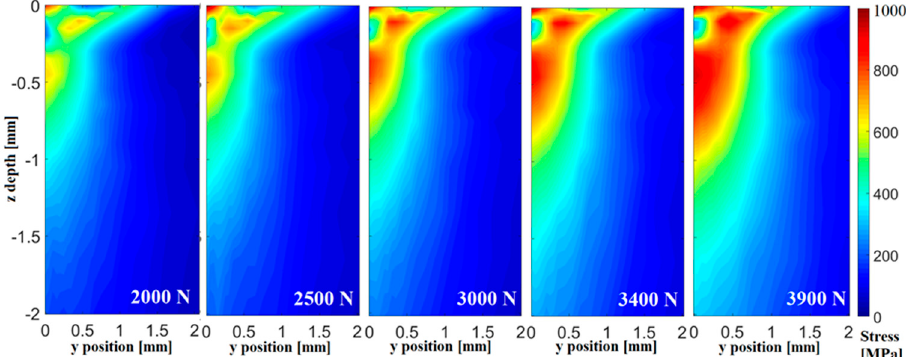
Figure 3. Equivalent stress maps (half fields) for σ eq ( y , z ) under load for 5 forces.